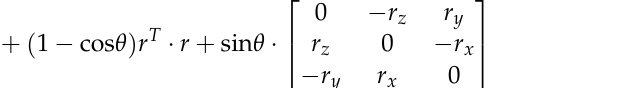
Figure 8. Inverse kinematics via the closed-form solution.